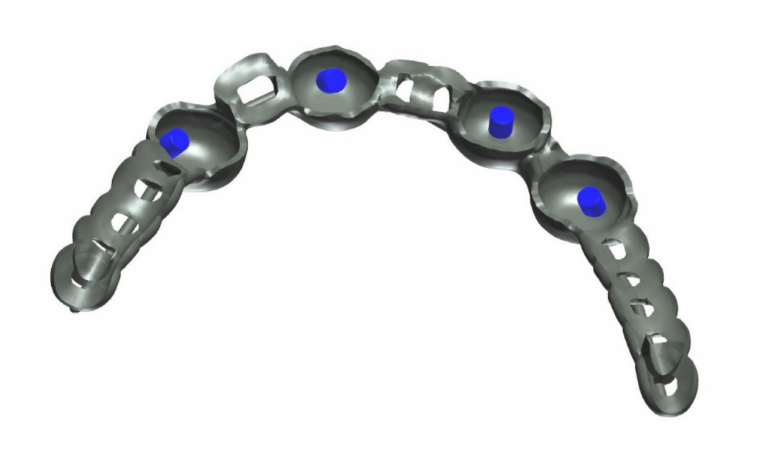
Figure 7. Close-up screenshot of the digitally constructed alloy framework.